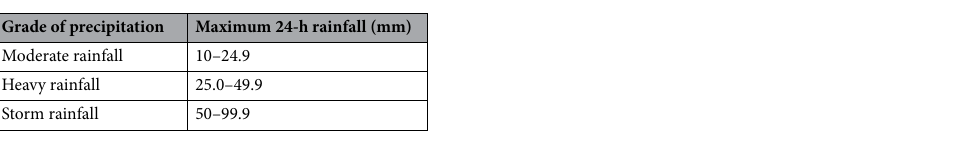
Table 1. Grade of